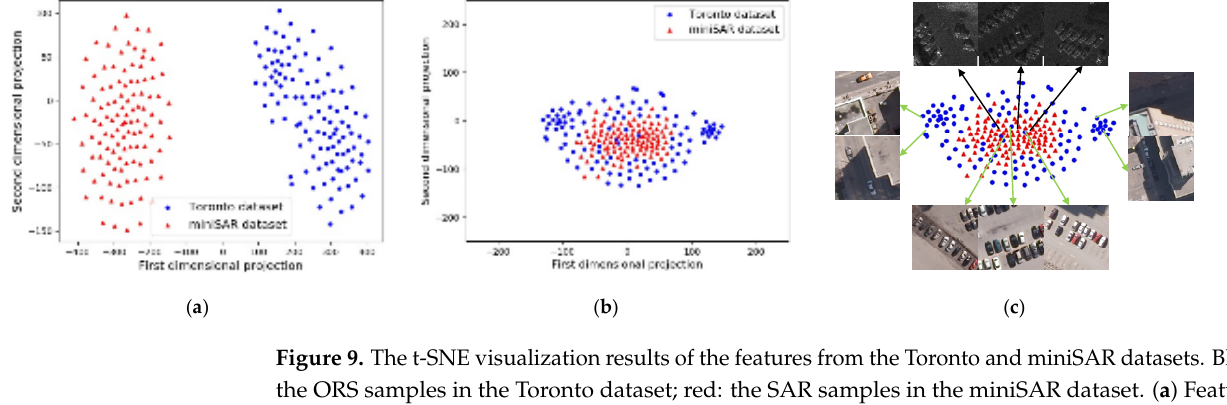
Figure 9. The t-SNE visualization results of the features from the Toronto and miniSAR datasets. Blue: the ORS samples in the Toronto dataset; red: the SAR samples in the miniSAR dataset. ( a ) Feature visualization for the SAR and ORS samples without adaptation. ( b ) Feature visualization for the SAR and ORS samples via the faster R-CNN with MMD. ( c ) Some examples of image chips corresponding to the features in ( b ).